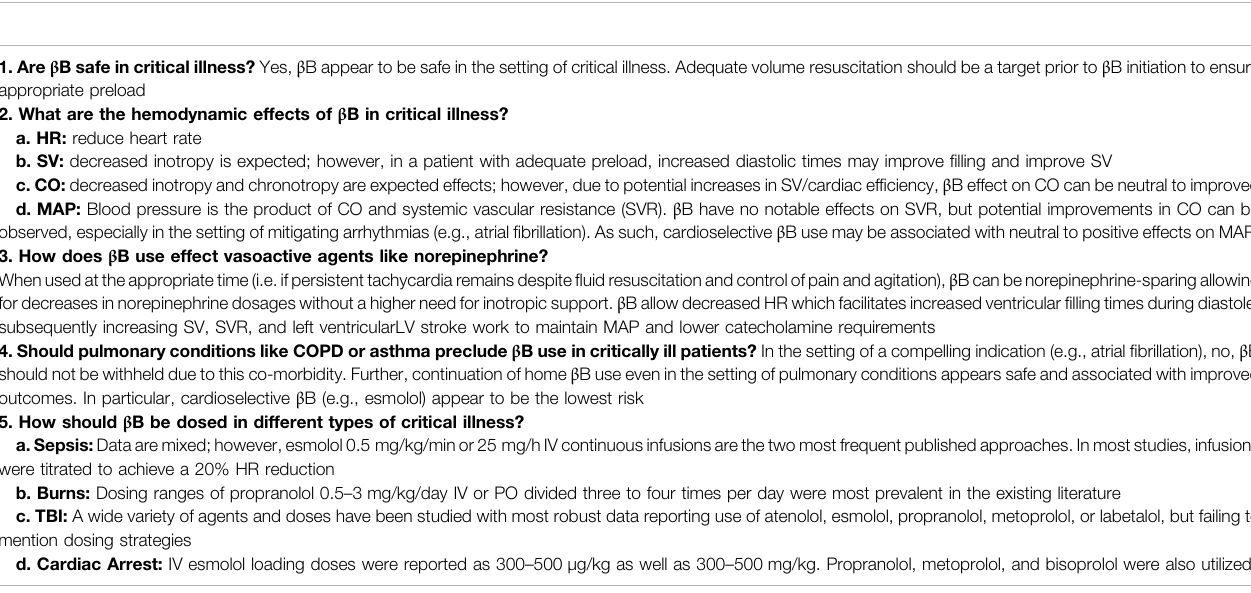
TABLE 2 | Practical questions regarding β B use in critical